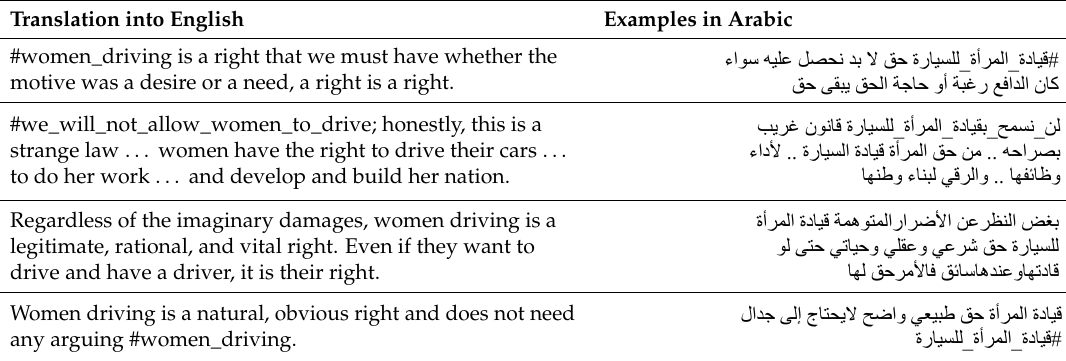
Table 3. Examples of normalizing women driving by promoting women’s independence.